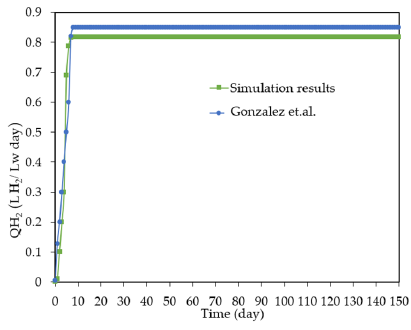
Figure 6. Validation of (QH 2 ) [24].